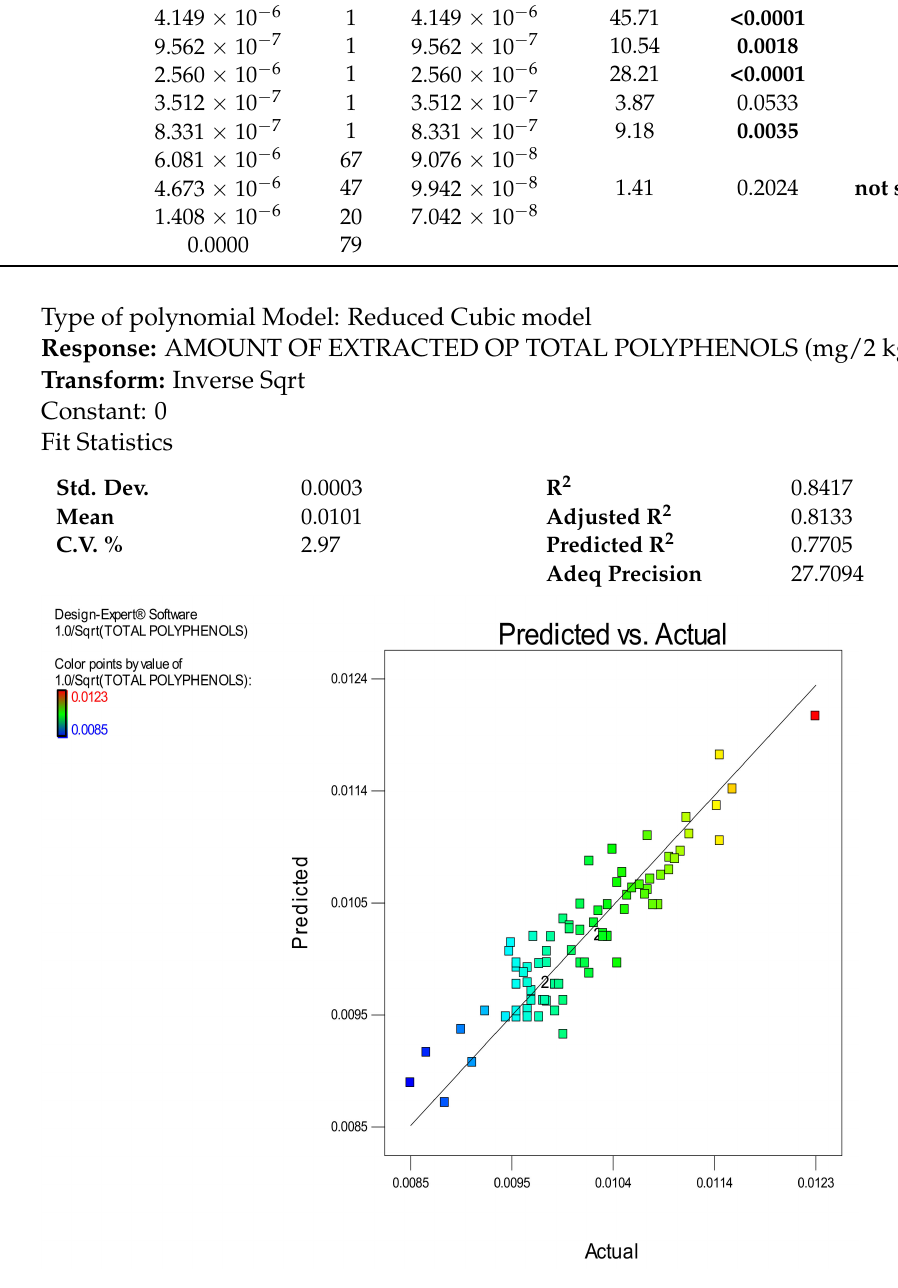
Figure 1. Correlation of Predicted vs. Actual values of the amount of the extracted orange pomace (OP) total polyphenols (mg